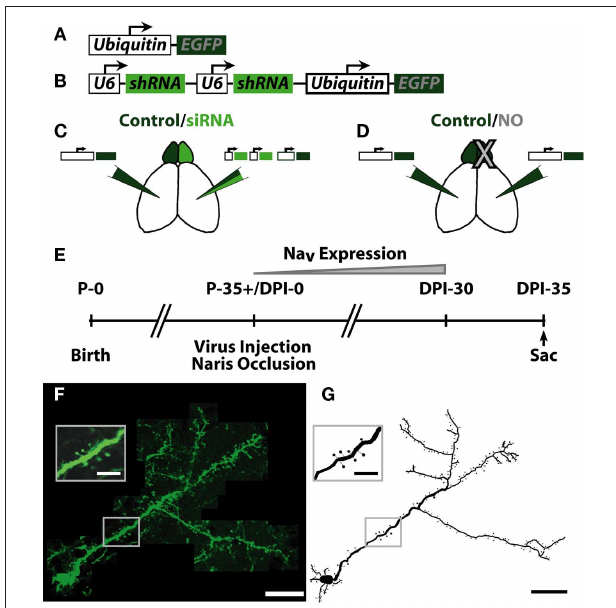
Figure 1 | Summary of experimental conditions and injection paradigm. (A) Schematic of EGFP coding lentivirus. EGFP was expressed downstream of the ubiquitin promoter. (B) Schematic of siRNA + EGFP coding lentivirus. Two U6 promoters, each expressing one shRNA against voltage gated sodium channel 1.1–1.3 (Na 1.1–1.3) expression were followed by the ubiquitin promoter V expressing EGFP. Each group received the following manipulations: (C) – Control